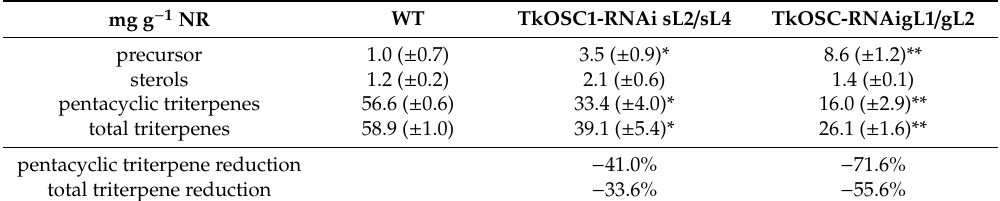
Table 1. Isoprenoid analysis of acetone extracts from NR obtained from TkOSC1 / TkOSC -RNAi and WT root material by GC–MS. Extracts were analysed from the material of two plants of sL2, one plant of sL4, one plant of gL1 and two plants of gL2, respectively, compared to WT material ( n = 3); asterisks denote statistical significance compared to control (two-tailed t test, * p < 0.05, ** p < 0.01); precursor: triterpene (squalene and 2,3-oxidosqualene) and sterol precursor (cycloartenol and 24-methylene cycloartanol); sterols: campesterol, stigmasterol and sitosterol; pentacyclic triterpenes: taraxasterol, α - and β -amyrin, lup-19(21)-en-3-ol, lupeol, taraxerol and four unknown triterpenes (free triterpenes (alcohols) as well as acetate derivatives); total triterpenes: precursor, sterols and pentacyclic triterpenes; single triterpene levels are shown in Table